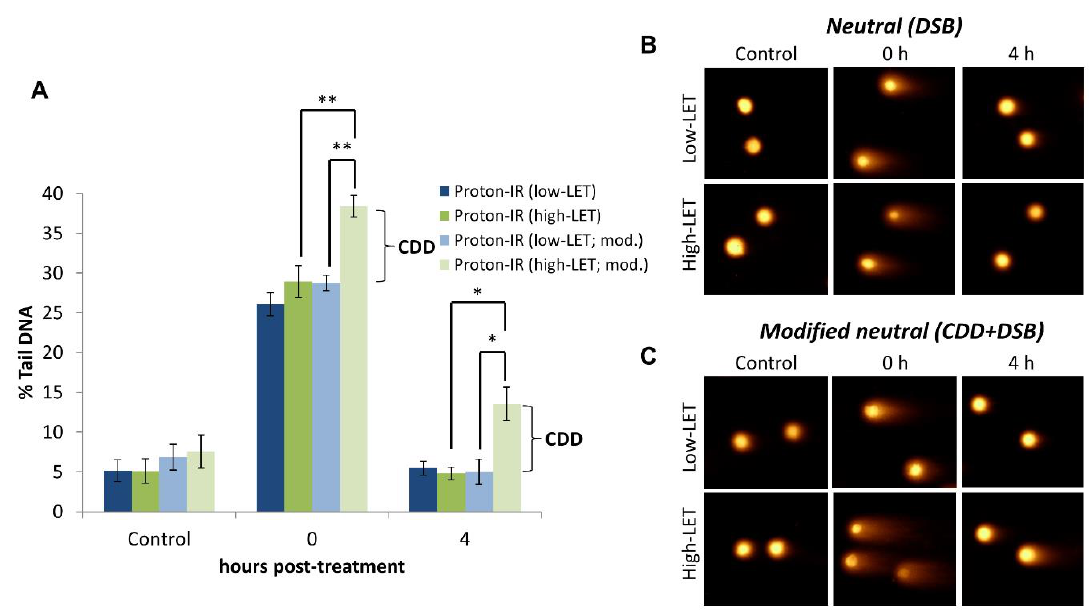
Figure 2. Demonstration of the induction and detection of CDD induced by relatively high-LET protons by the EMNC assay. ( A ) HeLa cells were either un-irradiated (control) or irradiated with 4 Gy protons at relatively high-LET (11 MeV = mean energy) or low-LET (58 MeV), with DNA damage measured immediately, and at 4 h post-irradiation by the EMNC assay. The levels and repair of DSBs are revealed in the absence of enzyme treatment, whereas, following enzyme treatment with APE1, NTH1, and OGG1 (indicated as mod.), this additionally reveals the levels of CDD. Shown is the % tail DNA ± S.D. * p < 0.01, ** p < 0.0005, as analyzed by a one sample t -test. Respective images of cells acquired in ( B ) absence and ( C ) following enzyme treatment pre- and post-irradiation are shown.